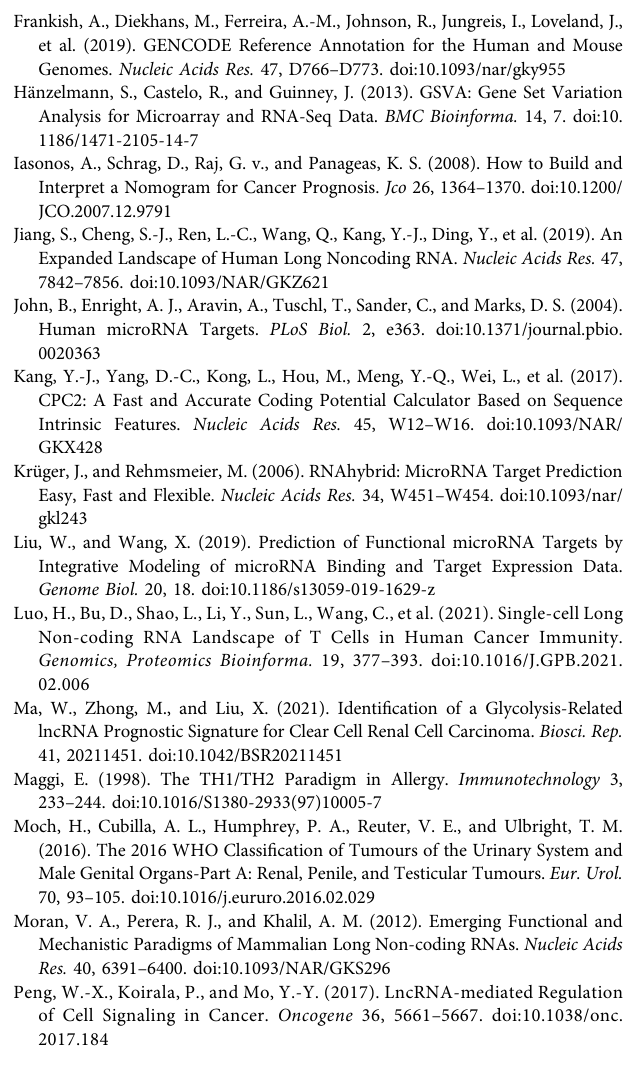
Supplementary Figure S4 | The volcano plot showed TR-miRNAs by comparing tumors with controls in RCC. The red color represented upregulated miRNAs and the blue color represented downregulated